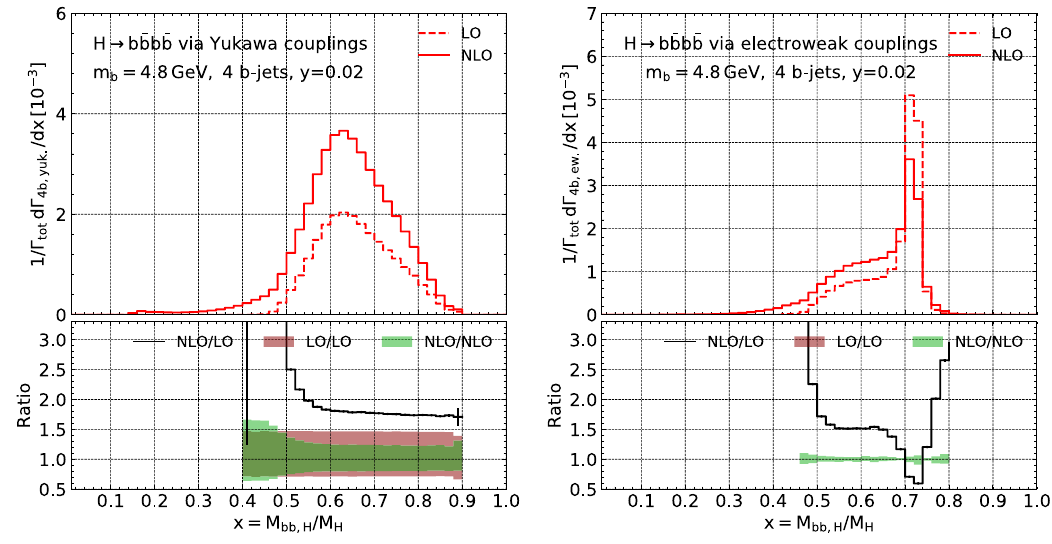
Figure 11 . Similar to figure 7 for distribution as a function of the highest invariant mass of all b -jet